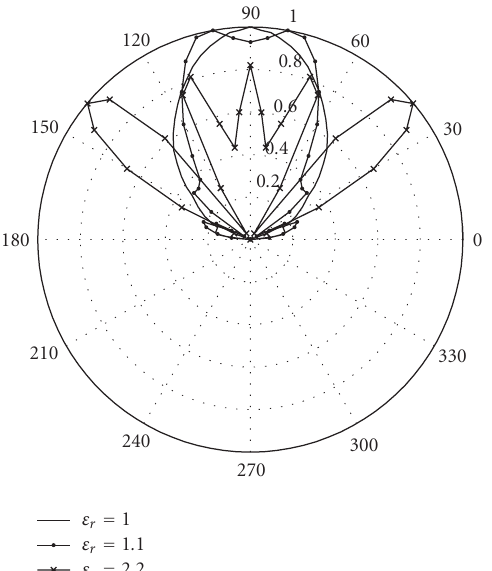
Figure 8: E -plane patterns for ε r = 1 . 0, 1.1, and 2.2.